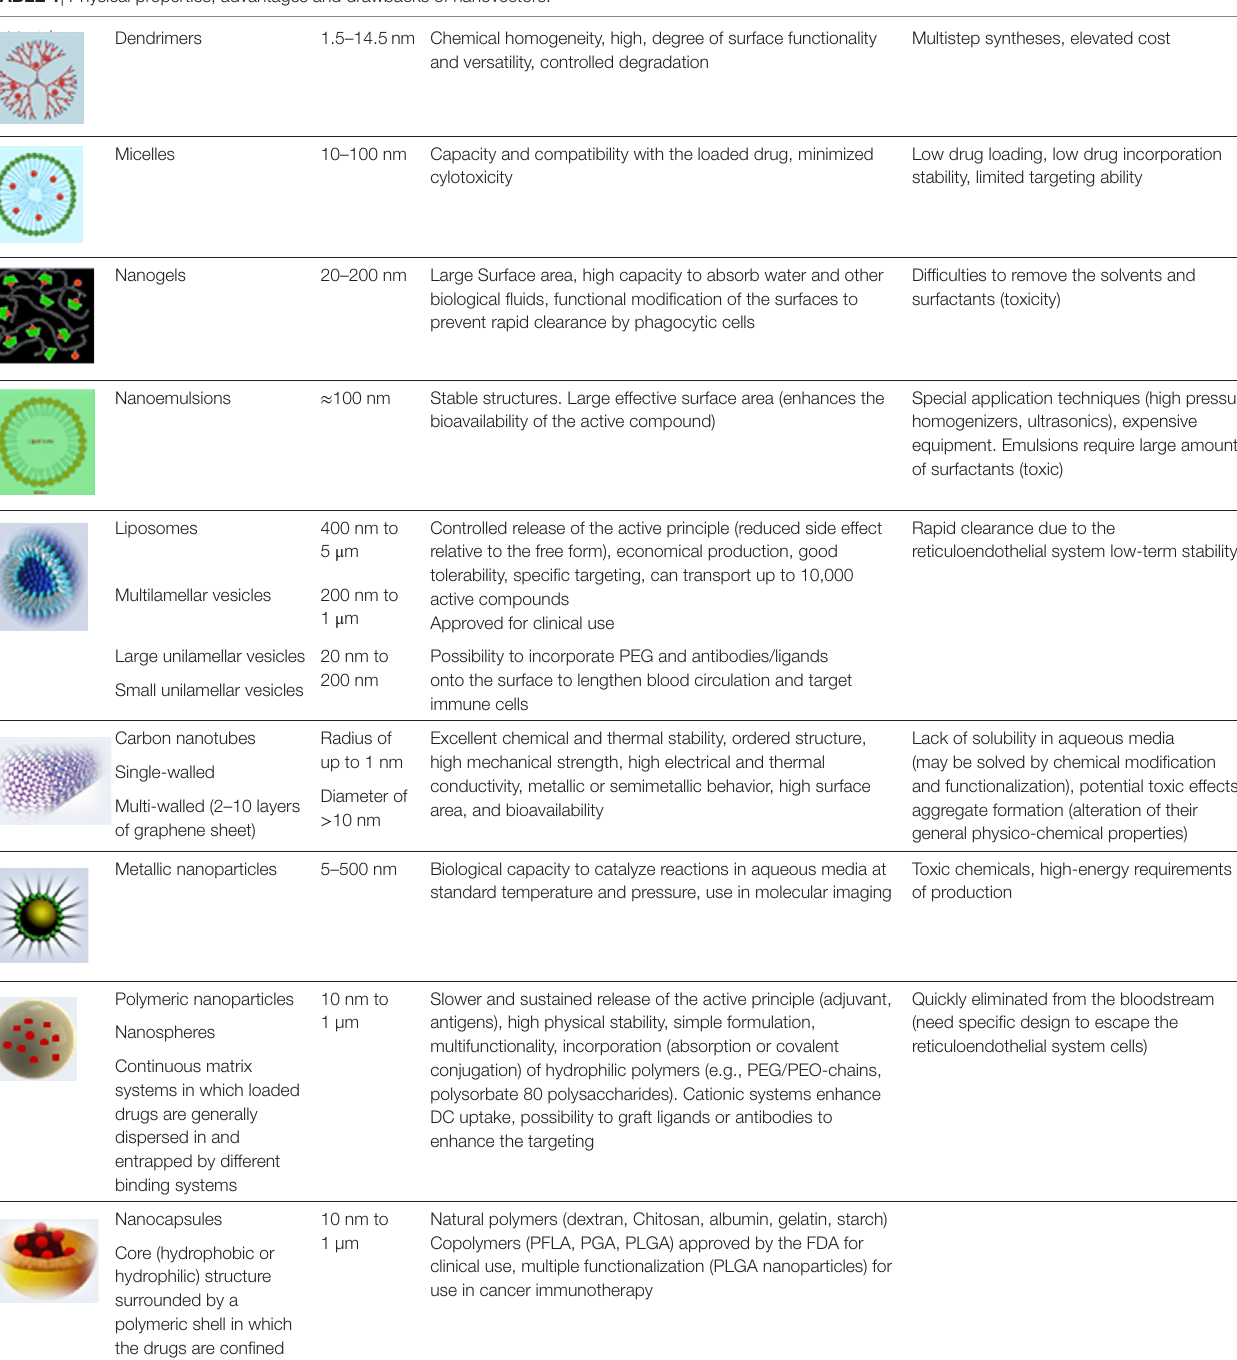
TAbLe 1 | Physical properties, advantages and drawbacks of nanovectors. Table 1